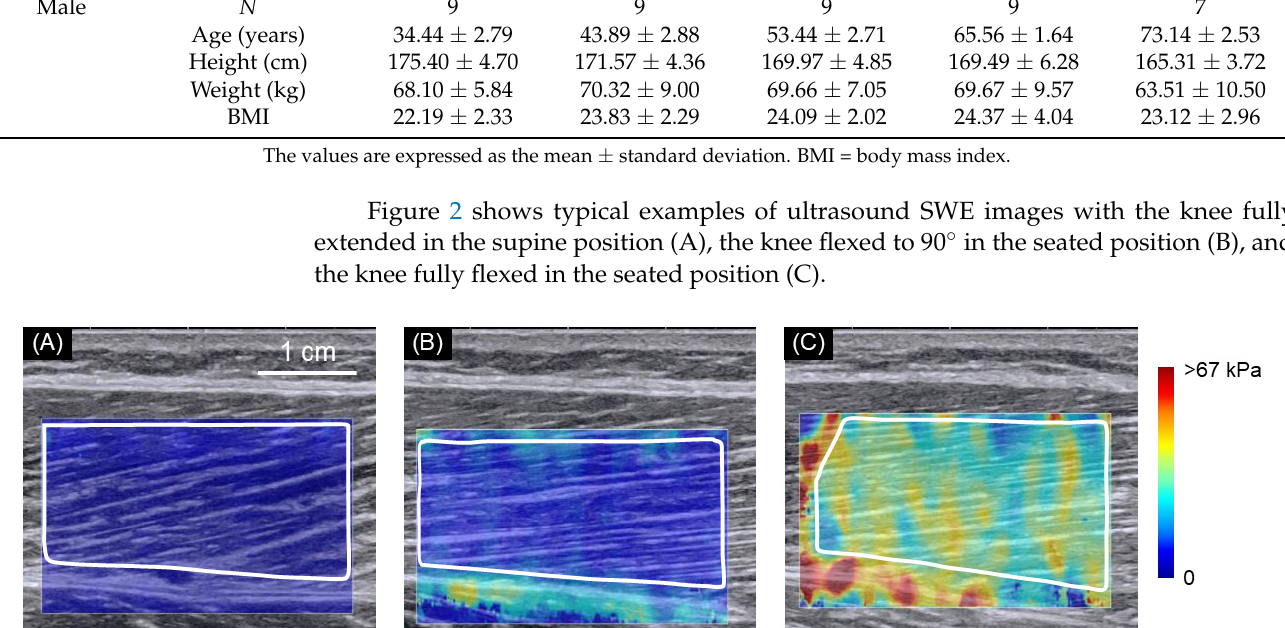
Table 2. Muscle shear modulus of the vastus lateralis (VL) of the females and males in each age group Age Group (years)